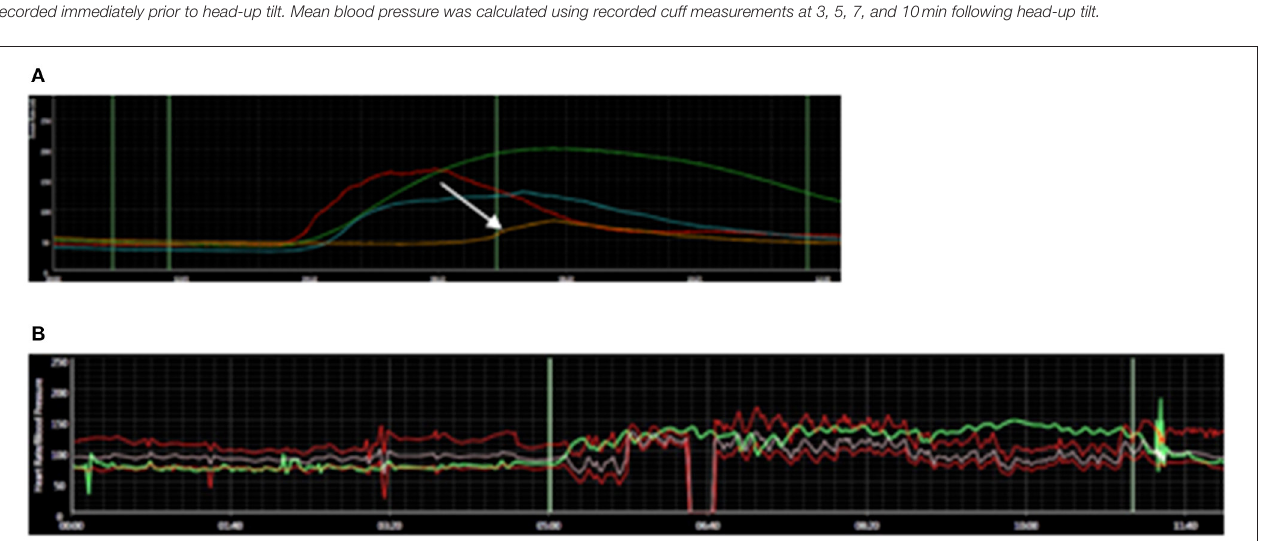
this series, and the study population was limited to patients with severe acute respiratory syndrome. In another large review of 841 hospitalized COVID-19 patients, dysautonomia was reported in 21 (2.5%) patients (1). Dysautonomia was considered